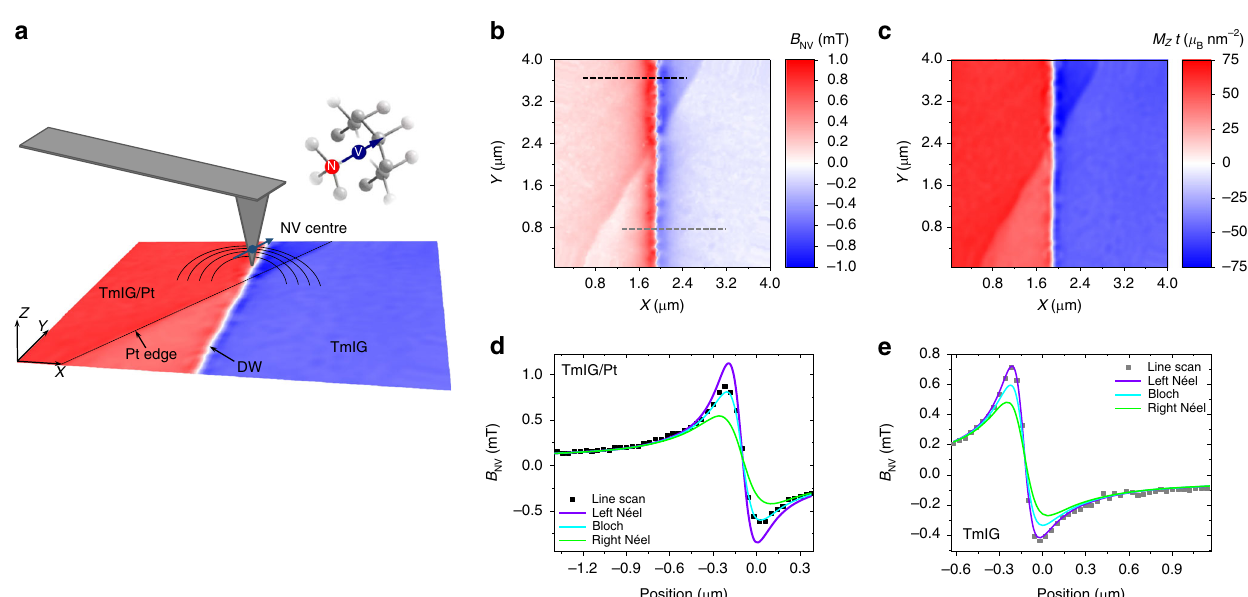
Fig. 2 Domain wall structure and chirality in TmIG and TmIG/Pt measured by scanning NV magnetometry. a Schematic of the NV probe and sample. The color code represents the out-of-plane component of the surface magnetization of the fi lm, with red (blue) corresponding to areas of opposite magnetization. A DW crosses the TmIG/Pt and TmIG regions. The inset shows a NV center within the diamond lattice and the corresponding spin quantization axis. b Stray fi eld B NV ( X , Y ) measured by scanning the diamond tip over the sample surface shown in a . c Reconstructed out-of-plane magnetic surface map M Z ( X , Y ) t from the data shown in b , where t is the thickness of the TmIG layer (see Methods) and μ B the Bohr magneton. The difference in the measured surface magnetization M Z t = (66.8 ± 1.5) μ B nm − 2 in TmIG/Pt and M Z t = (39.5 ± 2.2) μ B nm − 2 in TmIG is attributed to both the etching process and to proximity-induced polarization of the Pt layer (see Supplementary Notes 2 and 7). d , e Line scans of B NV along the dashed lines indicated in b (square dots). The solid lines are calculated B NV pro fi les using Eqs. (1 – 3) assuming pure Bloch ( ψ = 90°, cyan), left-handed Néel ( ψ = 180°, violet), and right-handed Néel ( ψ = 0°, green) DW structures for comparison with the measured stray fi eld pro fi les. M s t and Δ DW are set from the fi ts of the B NV ( X , Y ) ¼ ð 17 ± 17 Þ nm for TmIG/Pt, and ψ = (173 ± 17)° and Δ ¼ ð 27 ± 6 Þ nm for map. The fi ts give ψ = (116 ± 33)° and Δ DW DW